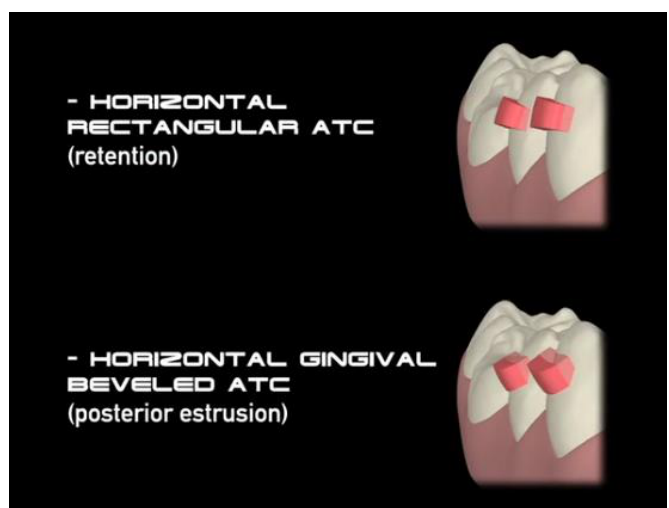
Figure 5. Different designs of lower premolars attachments.